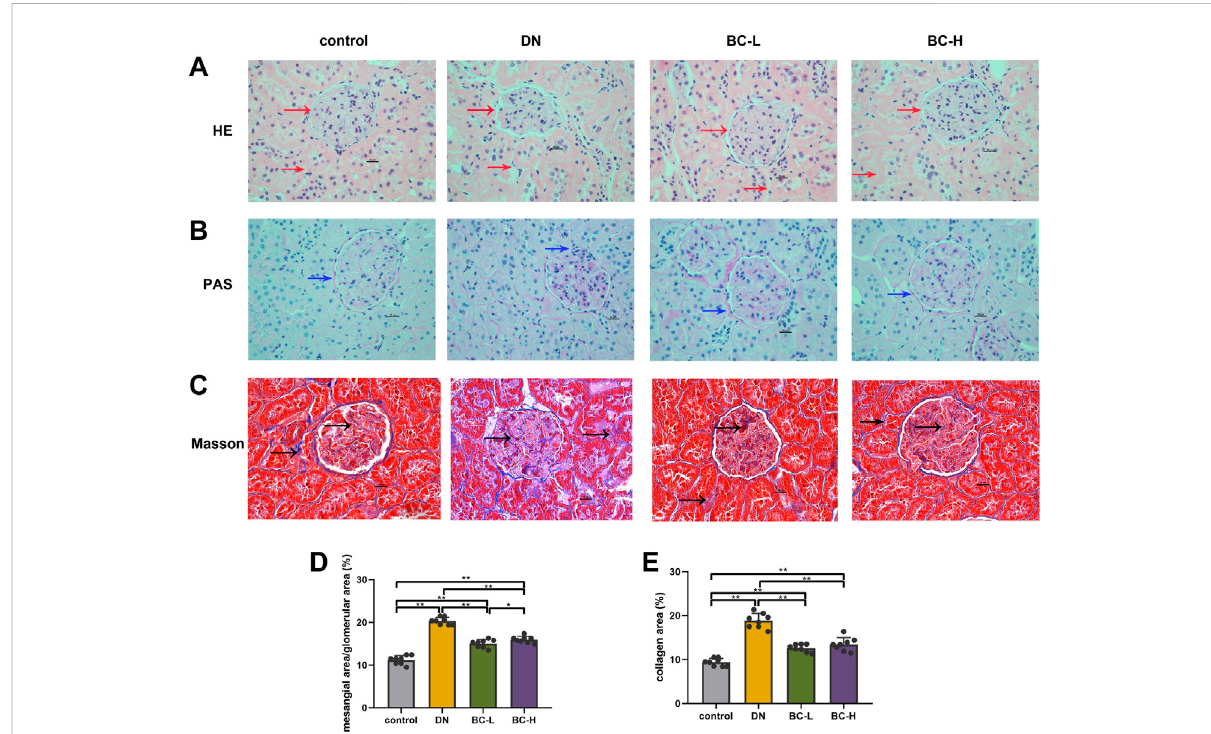
FIGURE 4 BailingCapsulealleviatedmorphologicalchangesofkidney. (A) H&Estaining(400X)ofkidneyshowedmorphologicalchangesinDNratkidney, including glomerular basement membrane thickening and tubular basement membrane thickening. Bailing Capsule treatment alleviated these changes. Red arrowshowed thebasement membrane. (B) PASstaining (400X) ofkidney showedmorphological changesinDNratkidney,including glomerular mesangial matrix accumulation. Bailing Capsule treatment alleviated these changes. Blue arrow showed glomerular mesangial matrix accumulation. (C) Masson staining (400 X) of kidney showed collagen fi ber deposition. Bailing Capsule relieved renal fi brosis in DN rats. The bluestainbytheblackarrowindicatediscollagens fi ber.Scalebar=20 μ m. (D) Thequanti fi cationofmesangialarea/glomerulararea(%)ofkidney. (E) The quanti fi cation of collagen area (%) of kidney. DN, diabetic nephropathy; BC-L, low dosage of Bailing Capsule; BC-H, high dosage of Bailing Capsule. Data are expressed as mean ± SD ( n = 8). * p < 0.05 and ** p <